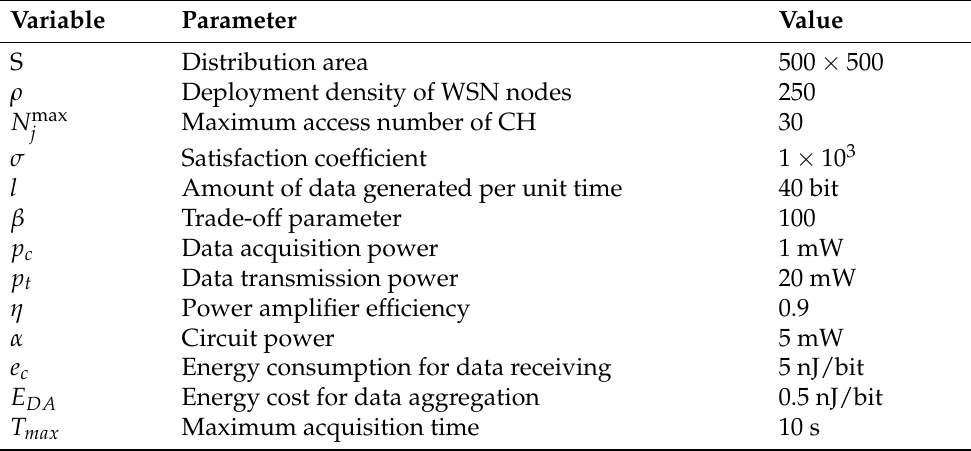
Table 1. Simulation parameters.